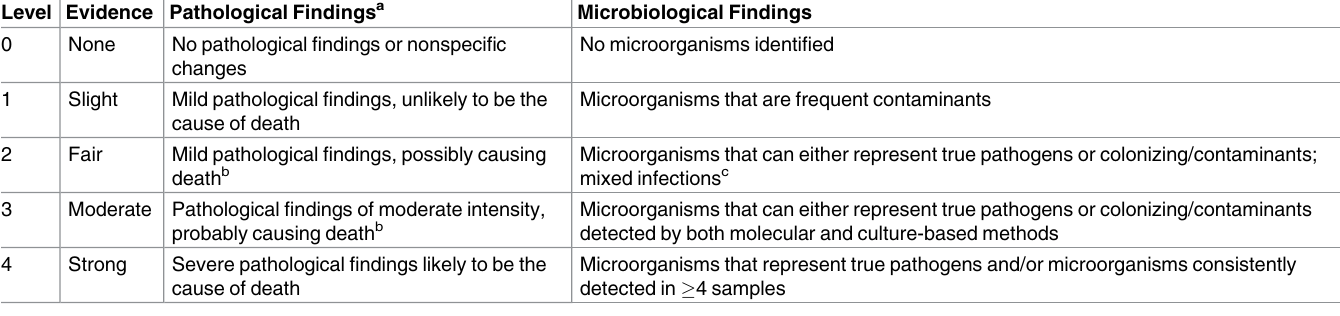
Table 1. Strength of the evidence of the autopsy findings identified in the complete diagnostic autopsy and the minimally invasive